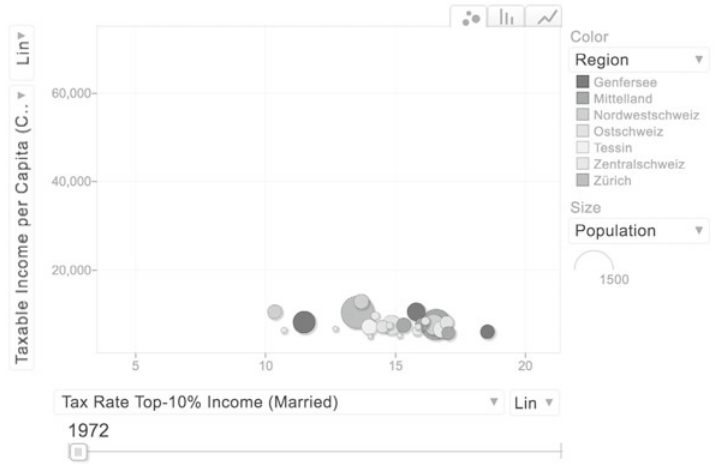
Figure 10: Taxable income per inhabitant (vertical axis) and Consolidated cantonal (cid:2) municipal effective tax rate for a married couple without children and top-10% income (horizontal axis) across Swiss cantons in 1972. Average across municipalities weighted by the number of taxpayers.